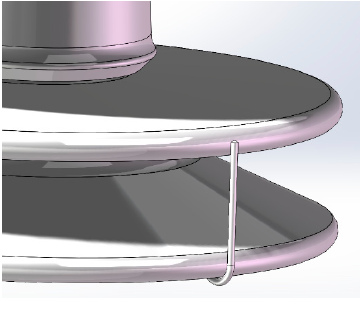
Figure 15. Partial arc in model.